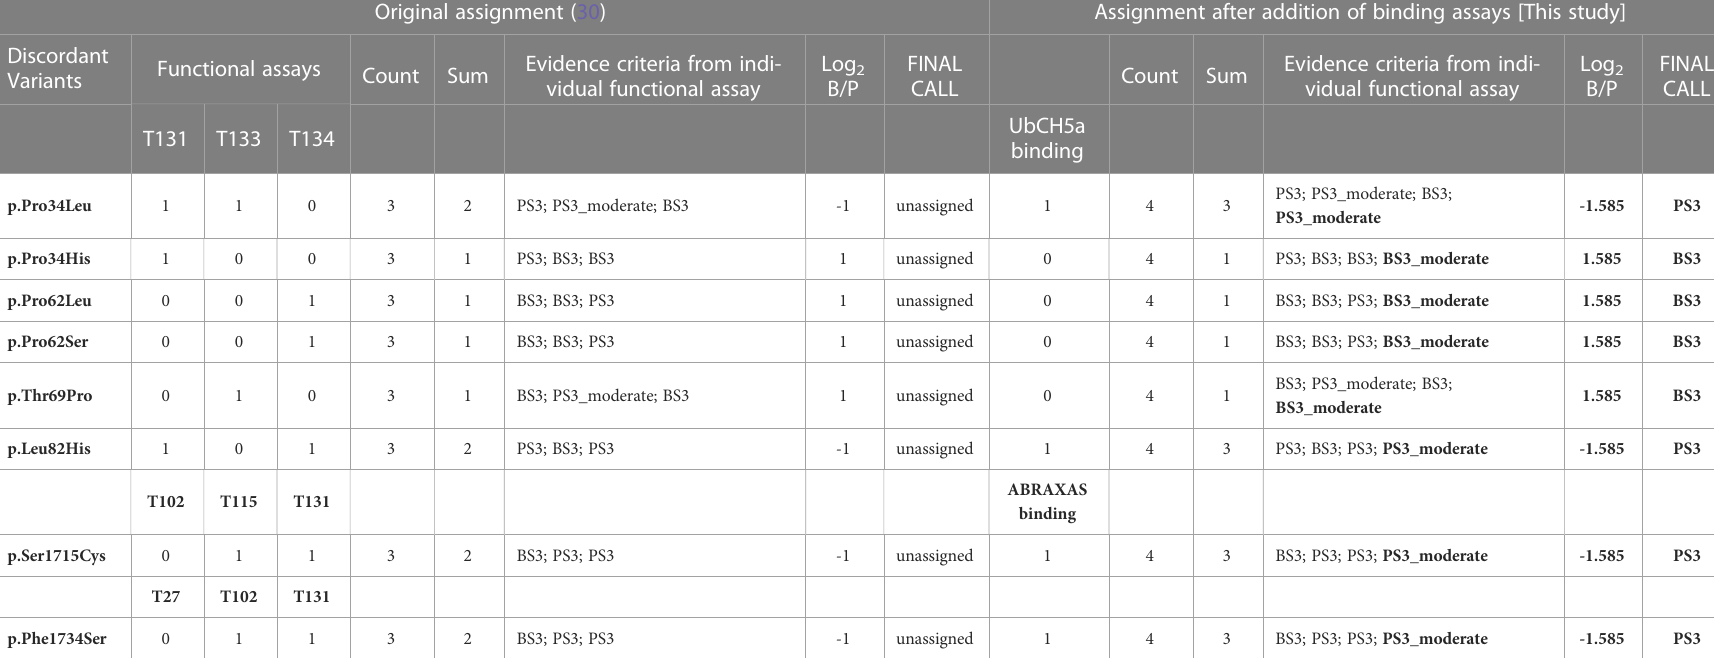
TABLE 2 Assignment of BS3 and PS3